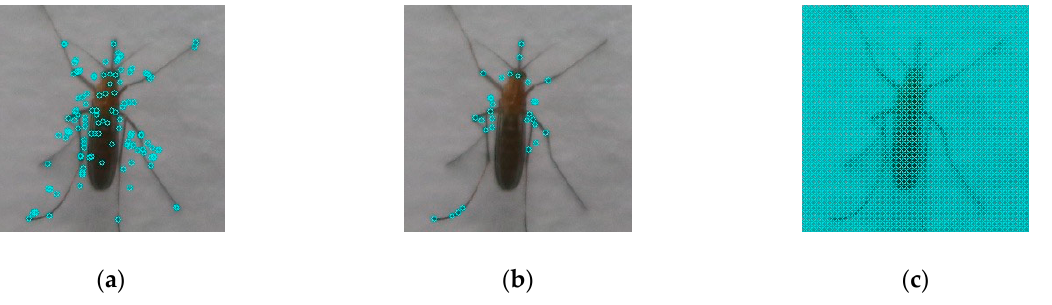
Figure 5. Visualization of keypoint detection: ( a ) Speeded-up robust features (SURF), ( b ) scale-invariant feature transform (SIFT), and ( c ) dense SIFT.